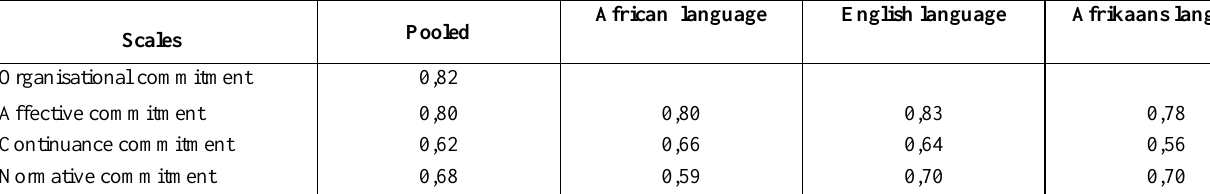
Table 3: Reliability coefficients for the TCM Survey Scales